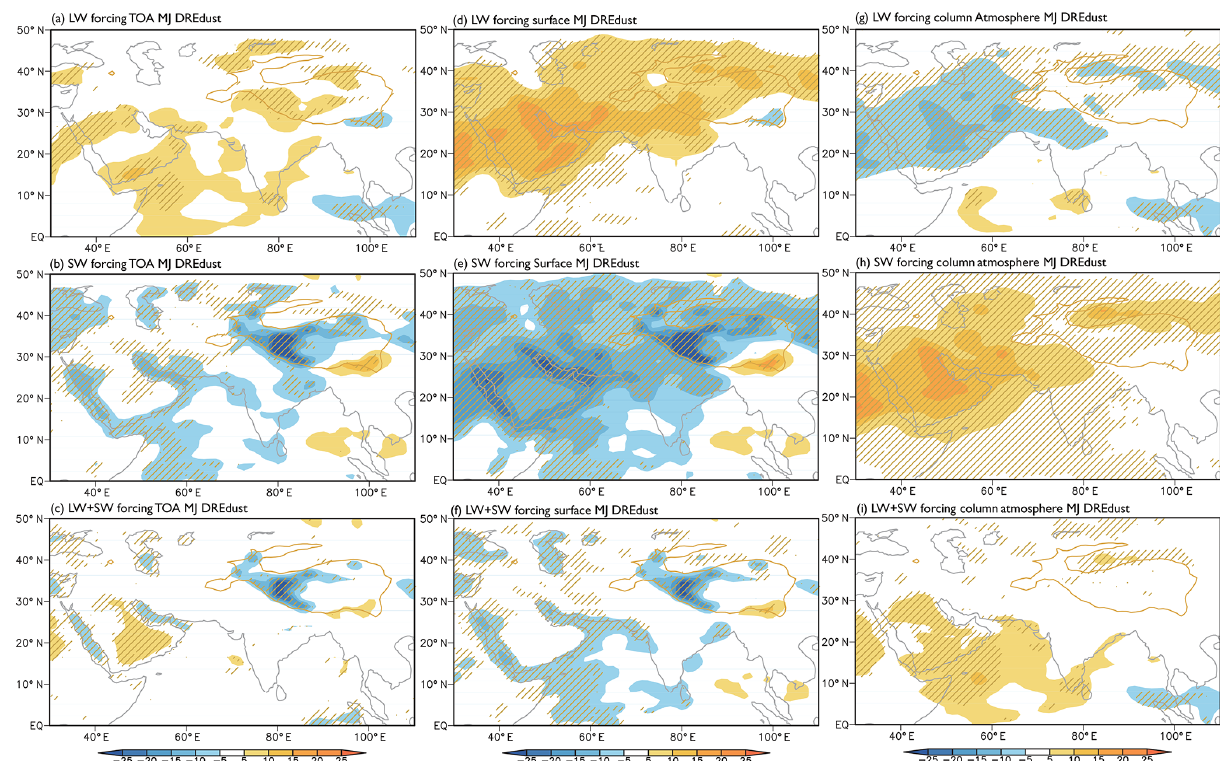
Figure 10. Similar to Fig. 9 but for the direct radiative effect of